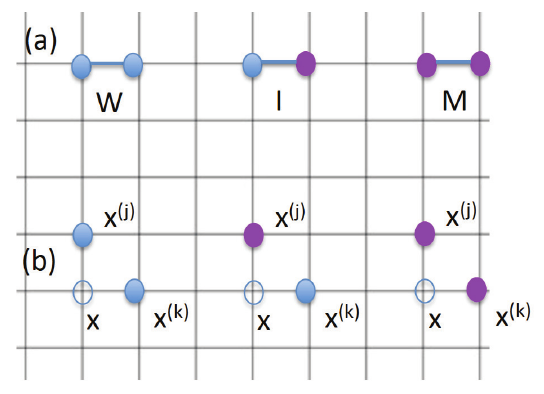
Figure 2. Steps in the derivation of equations for a two-component system of wild-type and mutant cells. Blue circles denote wild-type, and purple denote mutant cells. ( a ) Three configurations, whose correlations appear in Equations (19) and (20). ( b ) Three types of correlations needed for equations for W , I , and M